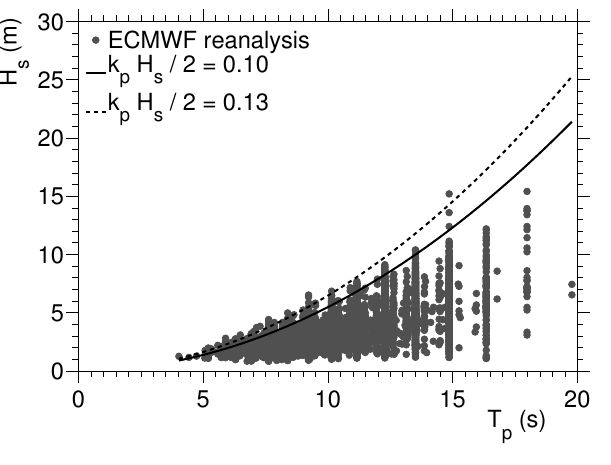
Fig. 6. Mean directional spread for events with H s > 6m and k p H s / 2 > 0 . 10 (ECMWF reanalysis